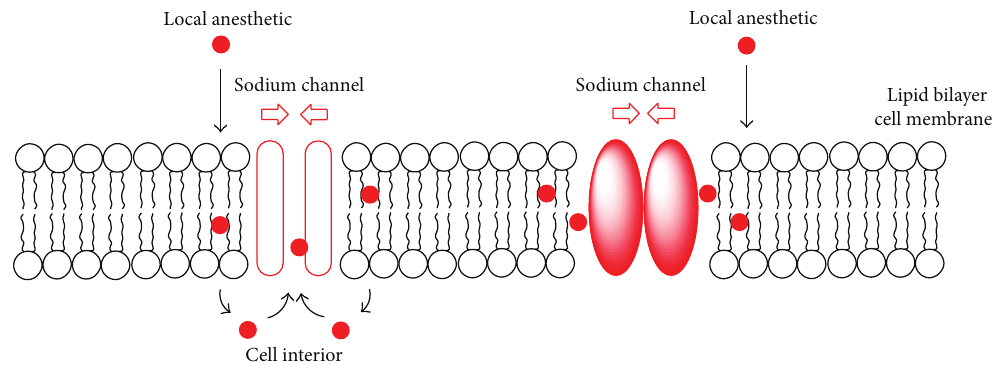
Figure 3: Channel protein-interacting and membrane lipid-interacting local